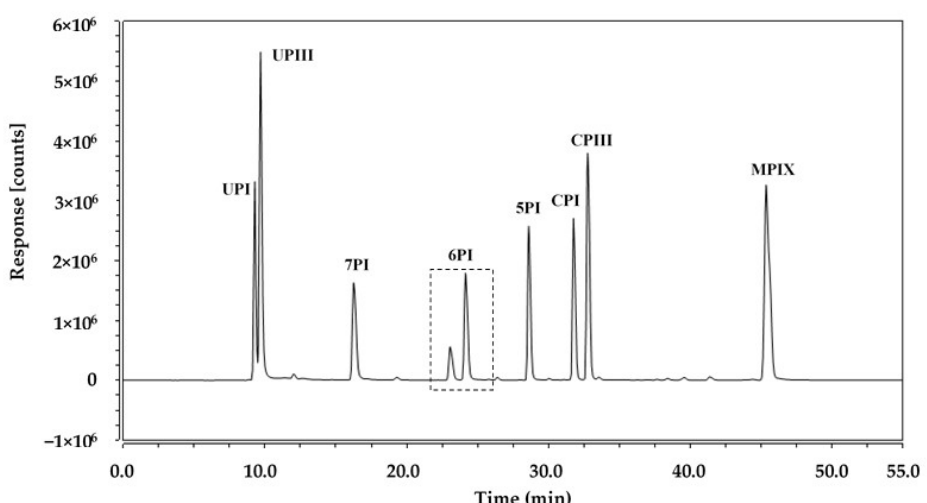
Figure 1. HPLC chromatographic profile of a porphyrin standard mixture. UPI: uroporphyrin I; UPIII: uroporphyrin III; 7PI: 7-carboxyl porphyrin; 6PI: 6-carboxyl porphyrin; 5PI: 5-carboxyl porphyrin; CPI: coproporphyrin I; CPIII: coproporphyrin III; MPIX: mesoporphyrin IX.